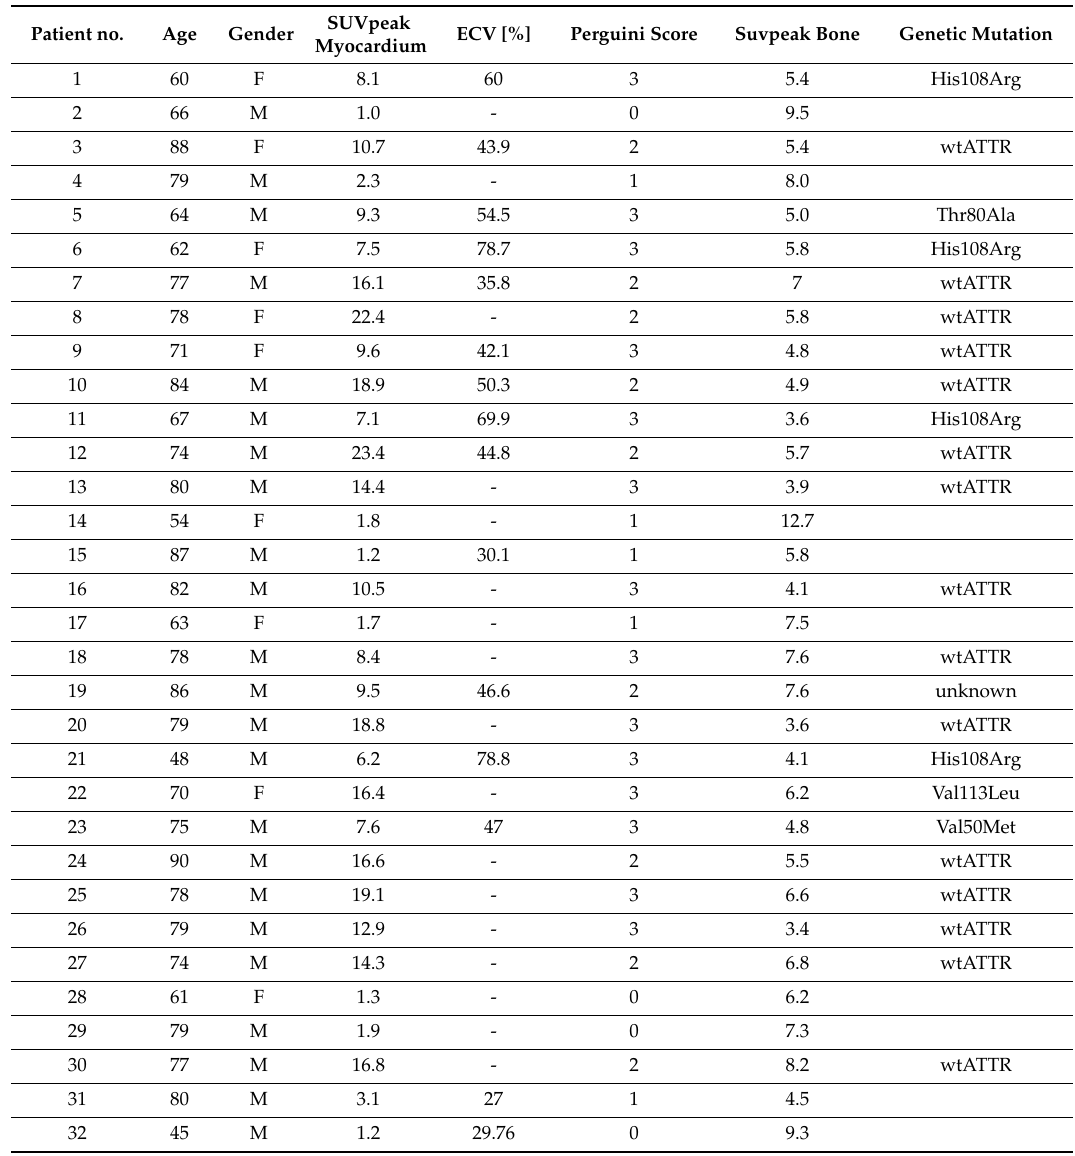
Table 1. Characteristics of the study cohort: The characteristics of the 32 patients included in the study with age, gender, myocardial and bone SUVpeak, ECV (if available), Perugini score and genetic mutation. Patient